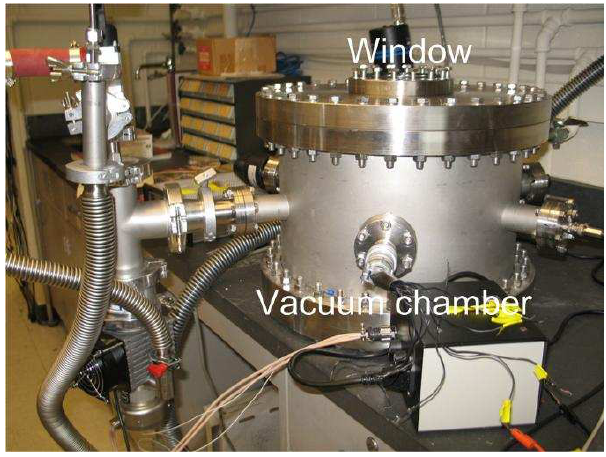
Figure 4. Photograph of the custom-built vacuum testing chamber. The chamber is equipped with a transparent window to enable radiative heating from outside the chamber, thus reducing electrical